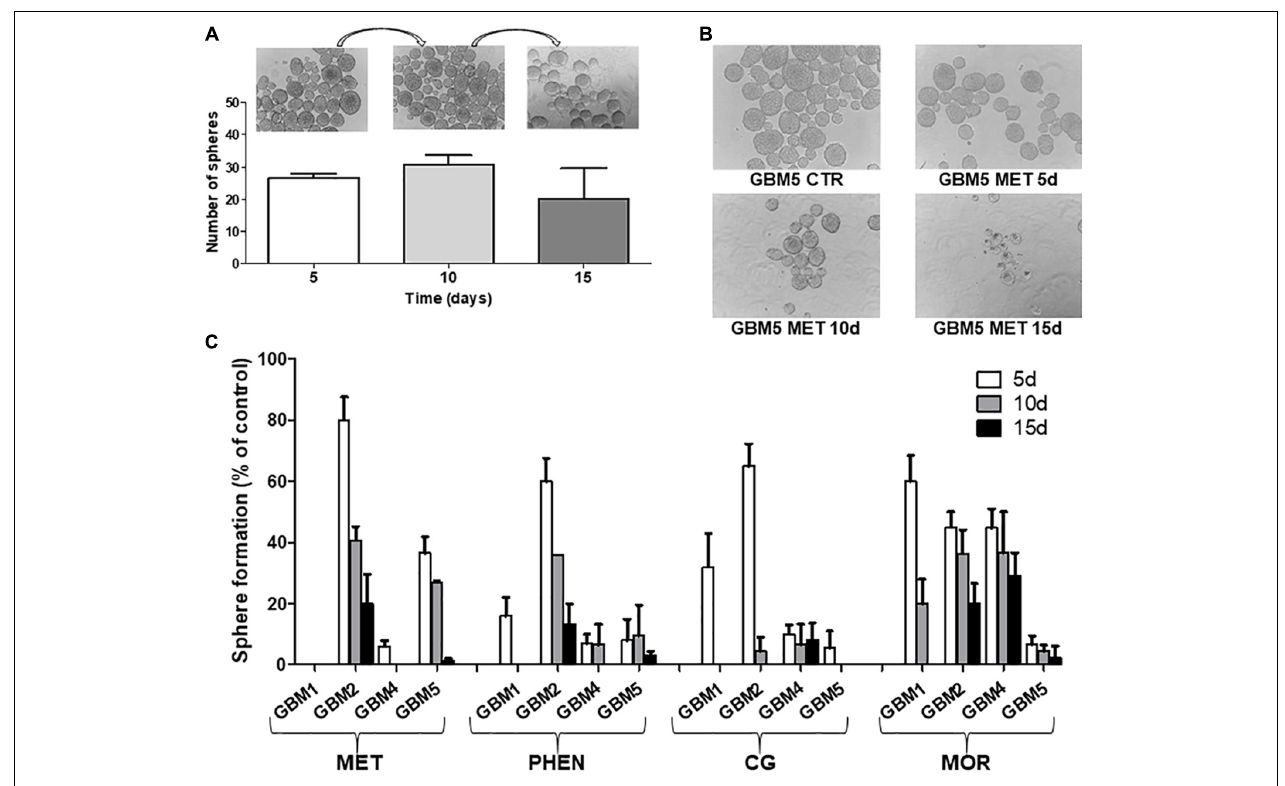
FIGURE 6 | Biguanide treatment impairs sphere formation in glioblastoma stem cells. (A) GSC cultures possess self-renewal capability. Sphere formation assay was performed on four GSC cultures (GBM1, GBM2, GBM4, and GBM5); images of spheres were captured and counted as described in Section “Materials and Methods.” On day 5, primary spheres were dissociated into single cells and 1000 cells subjected to another round of sphere formation assay, counted on day 10 (secondary spheres) and re-plated for the third time to asses sphere formation on day 15 (tertiary spheres). Representative microphotographs (magnification 10 × ) and histograms quantifying sphere formation from GBM5 cells, are reported. Sphere formation assays were performed on GBM1, GBM2, GBM4, and GBM5 GSCs, and measurement of primary, secondary and tertiary sphere number was assessed on day 5, in control and cultures with metformin (MET, 10 mM), phenformin (PHEN, 0.25 mM), cycloguanil (CG, 0.2 mM), and moroxydine (MOR, 1 mM). (B) Representative microphotographs (magnification 10 × ) of GBM5 treated with metformin (10 mM) are reported. (C) Quantification of biguanide impairment of sphere formation in GBM1, GBM2, GBM4, and GBM5. Histogram depicts the time-course of the percentage of spheres developed in treated cultures after 5 days of exposure as compared to controls (5 days); after sphere disaggregation, single cells were grown in the absence of drugs, and the formation of secondary spheres was evaluated on day 10 and, following further sphere dissociation, on day